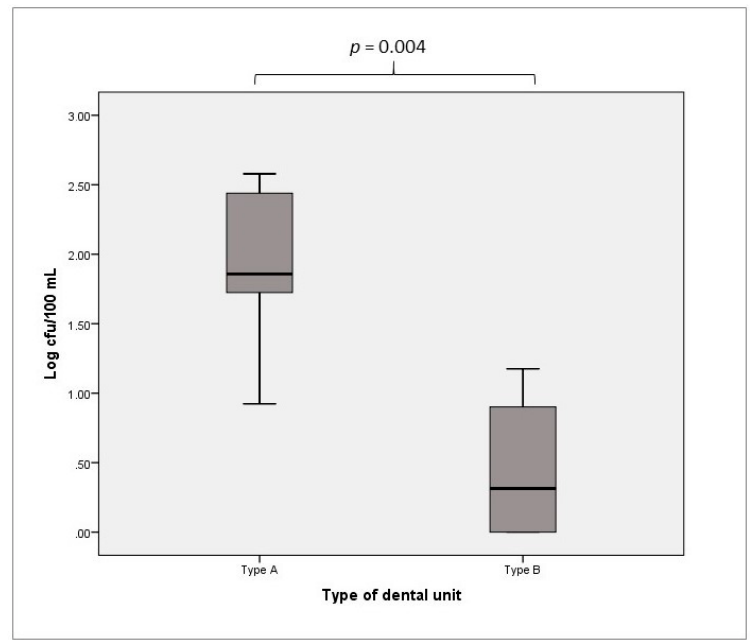
Figure 2. P. aeruginosa contamination of Type A vs. Type B DUWLs.